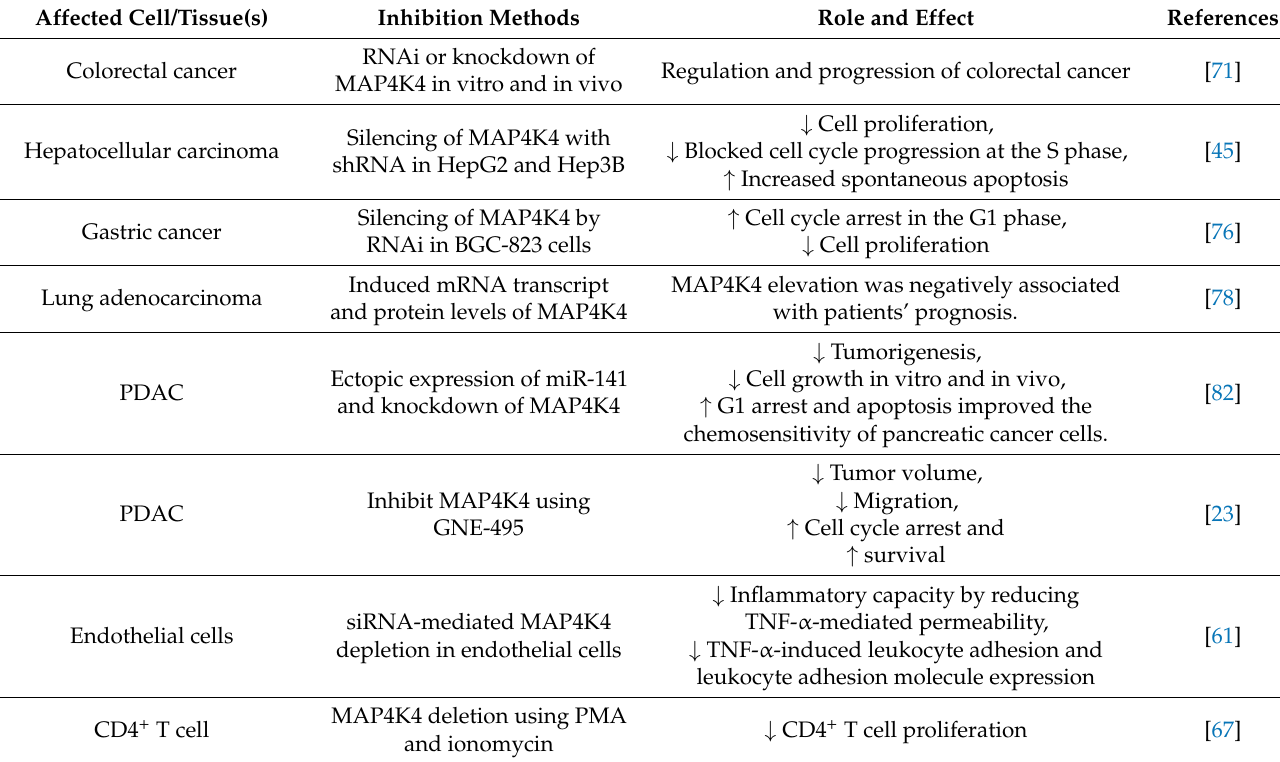
Table 1. MAP4K4 involvement in metabolic disorders and different types of